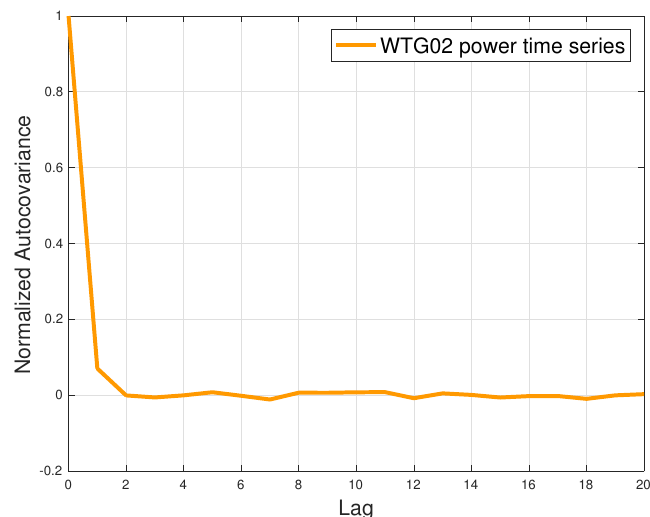
Figure 2. The normalized autocovariance of WTG02 power output (D bef dataset) with maximum lag of 20.